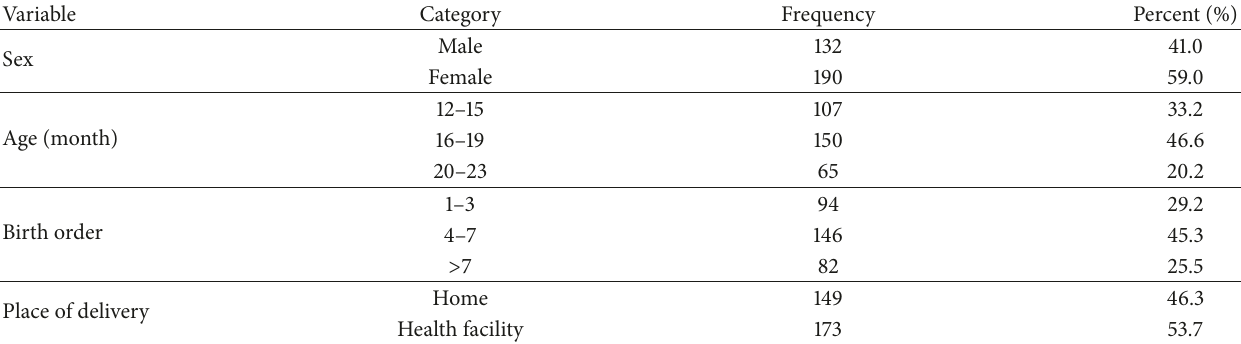
Table 2: Sociodemographic characteristics of children aged 12–23 months at Mizan Aman town, Bench Maji zone, Southwest Ethiopia,